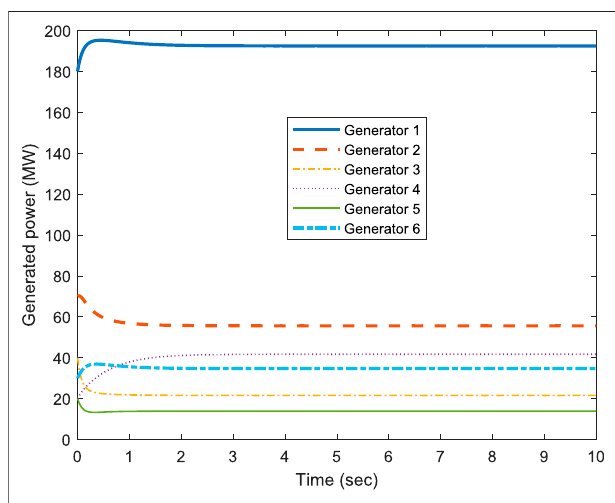
FIGURE 6 | Power generations (MW) of individual generators versus time (sec) using the proposed approach ( via weight selection), w 1 = 1.1, w 2 = w 3 = w 4 = w 5 = 1.025 and w 6 = 0.8.